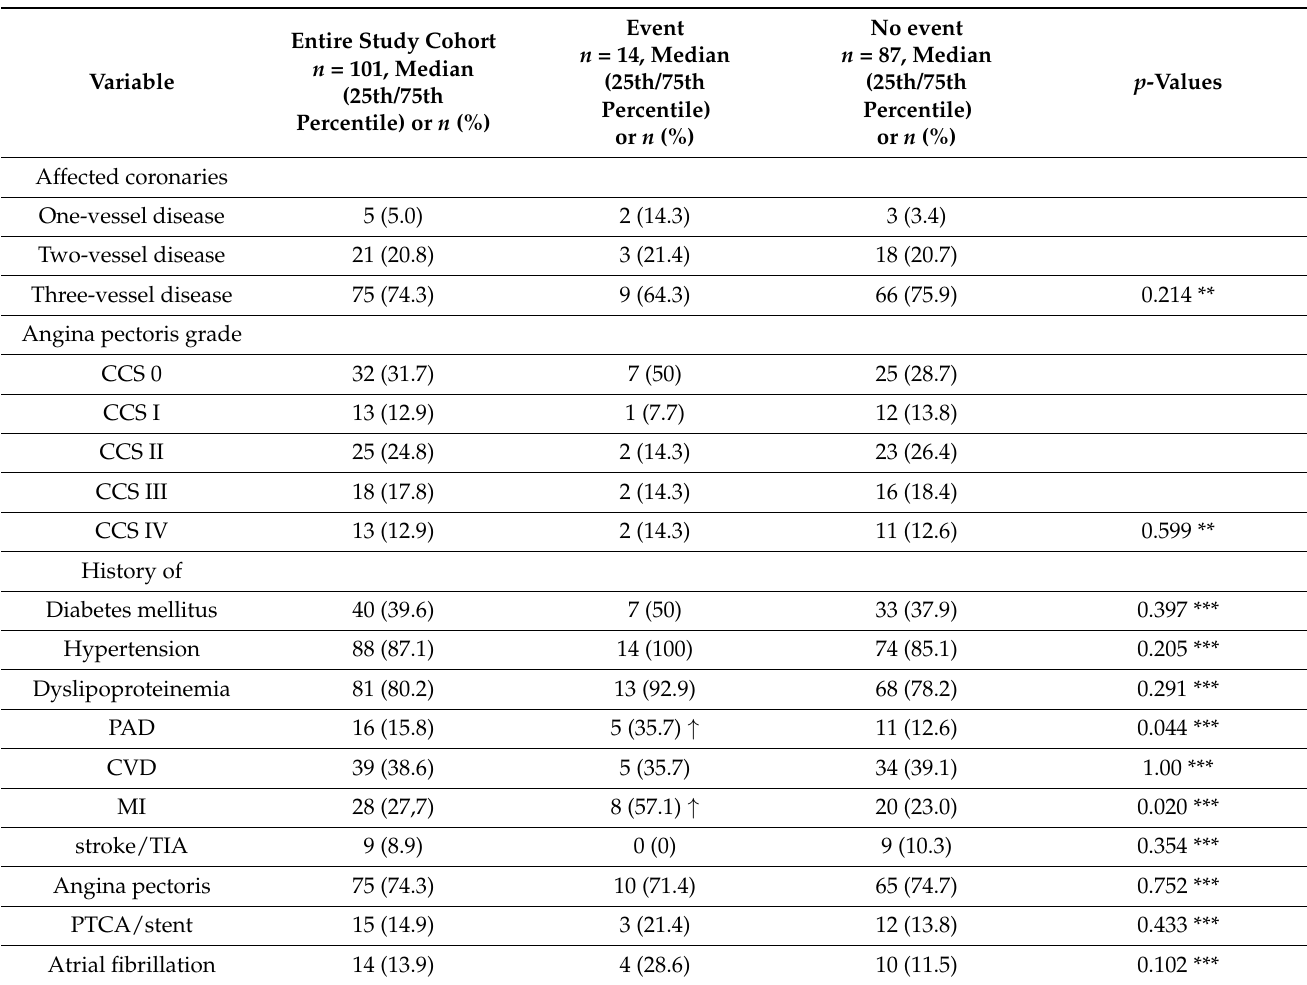
Table 2. Anamnestic and clinical parameters in dependence of the occurrence of adverse cardiovascular events one year after CABG